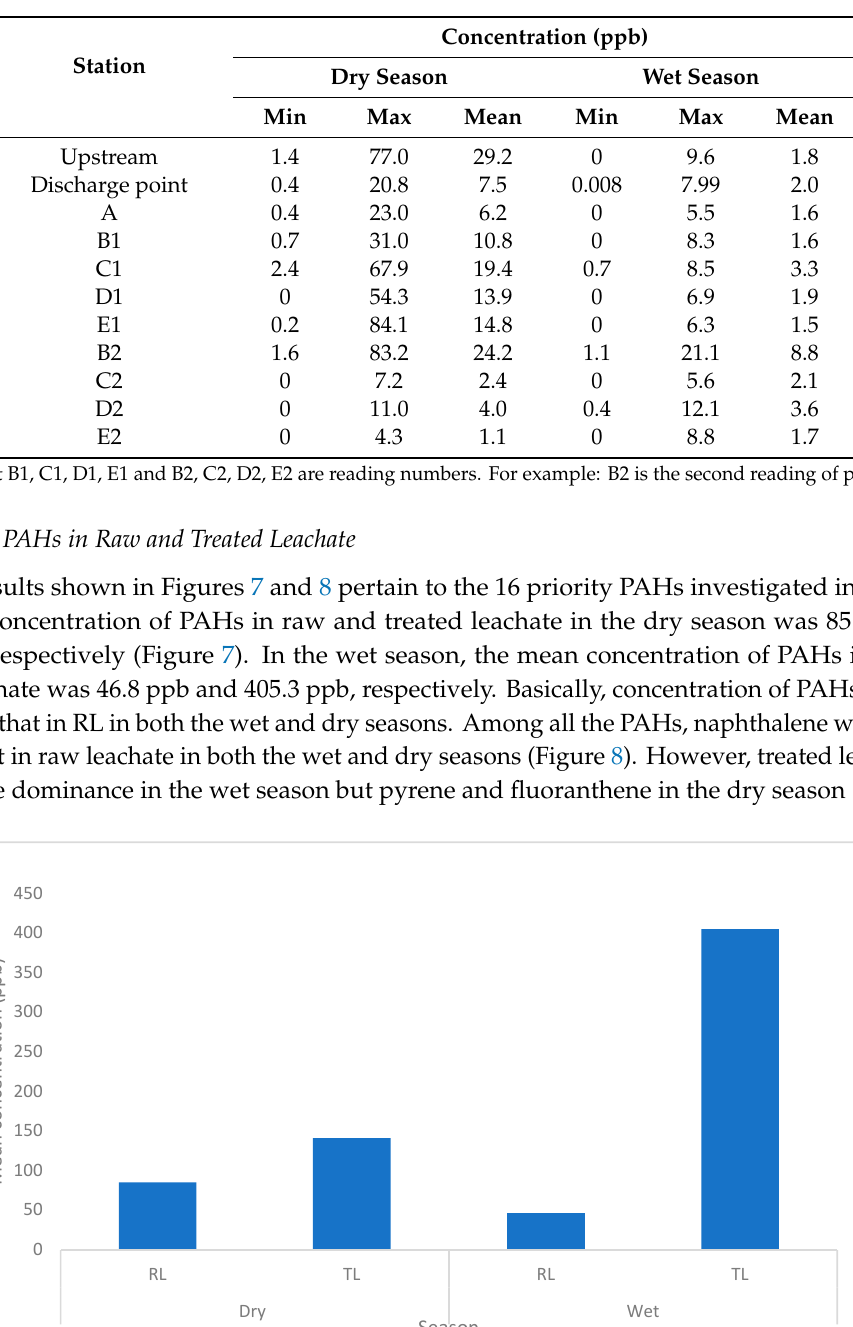
Table 7. Average of 16 PAHs concentration in the wet and dry season.